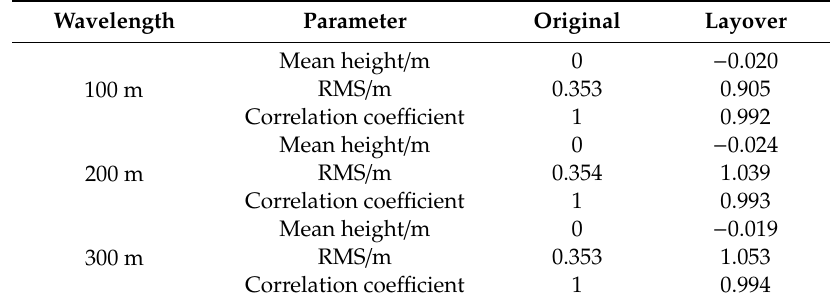
Table 7. The influence of layover under di ff erent wavelength (the propagation direction is 0 ◦ , the SWH is 2